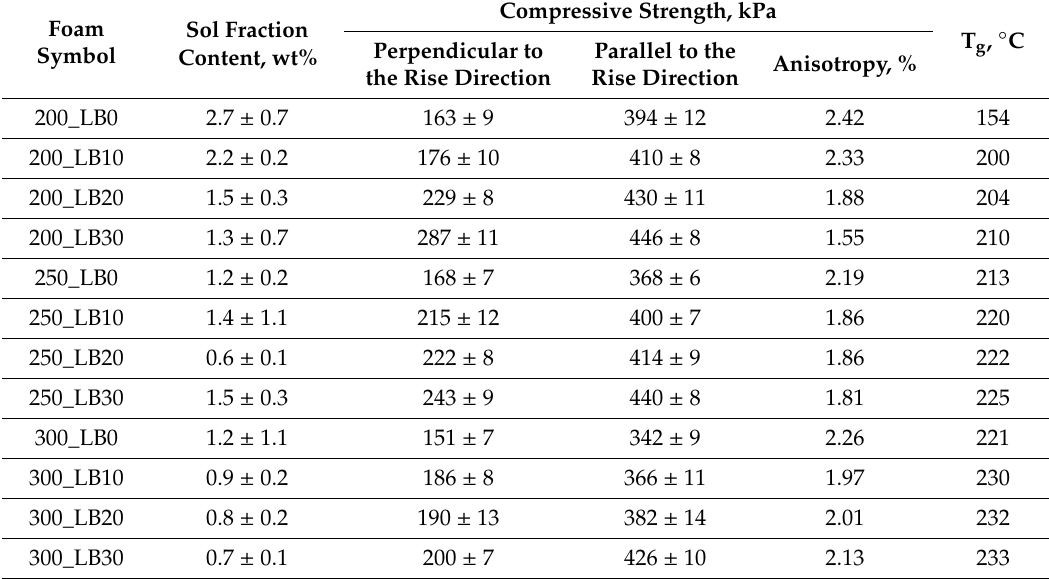
Table 7. Physical and mechanical properties of PUR-PIR